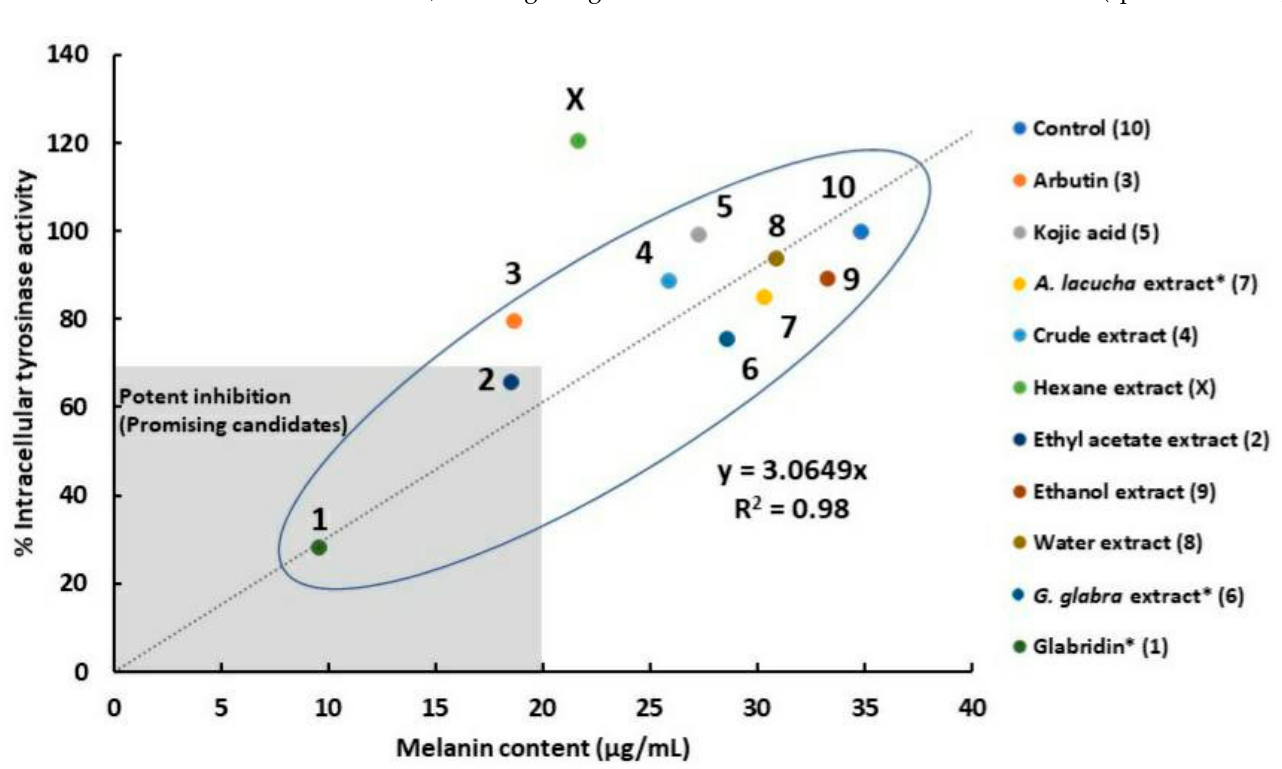
Figure 6. A linear relationship between % intracellular tyrosinase activity and melanin content ob- tained from positive controls (Arbutin, 8; Kojic acid, 5; A. lacucha extract, 7), remedy extracts (crude, 4; hexane, X; ethyl acetate, 2; ethanol, 9; water, 8), and active ingredients ( G. glbra extract, 6; glabridin, 1). * Indicates samples tested at a concentration of 5